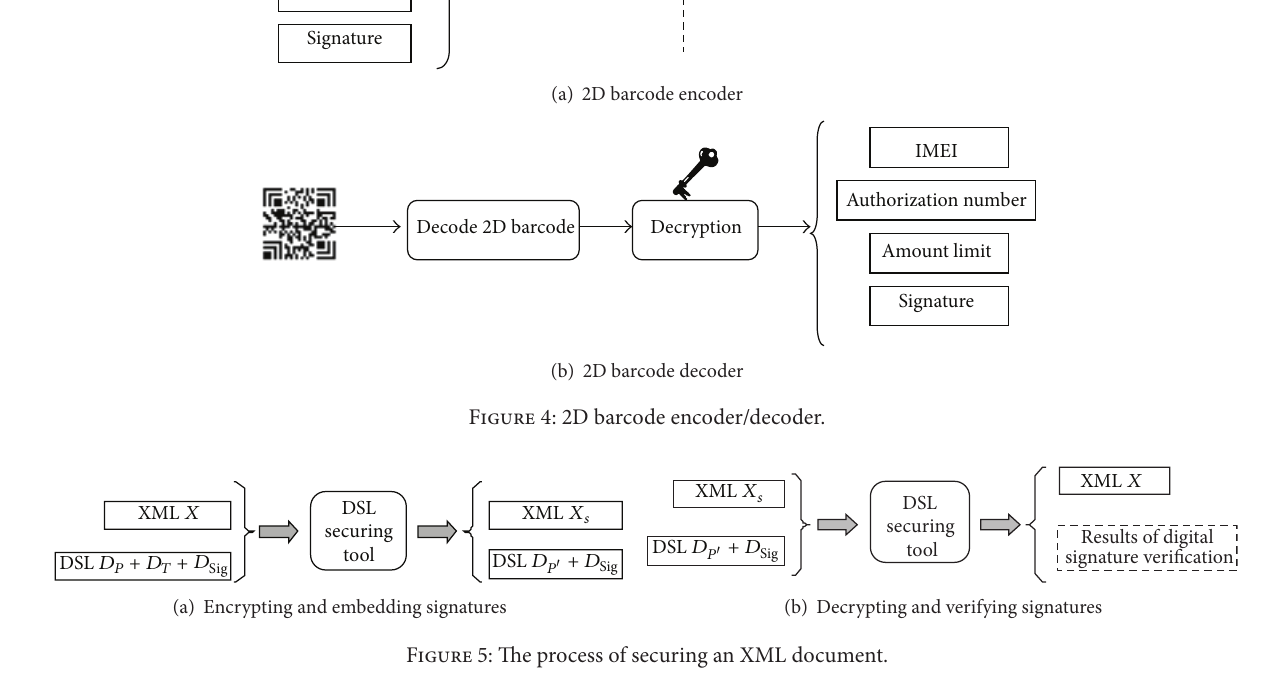
Figure 5: The process of securing an XML document.